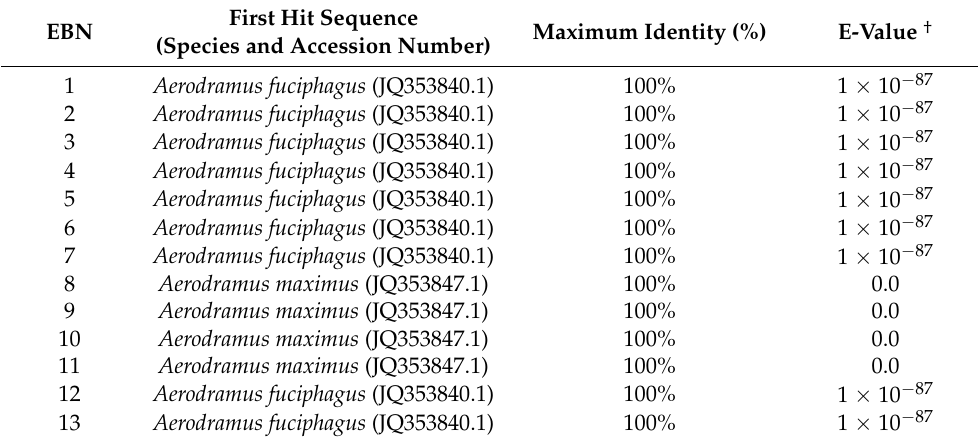
Table 3. BLAST results on GenBank with first hit sequence using 406 bp of cytochrome b gene